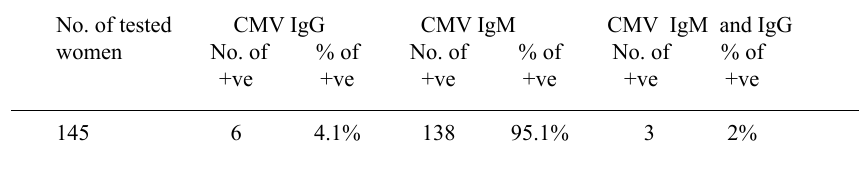
table 1. The seroprevalence rate of anti-CMV IgM)